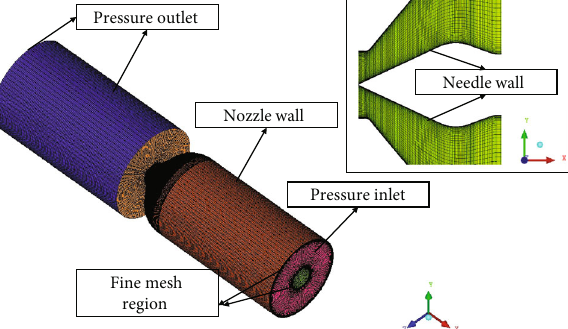
Figure 6: Initial readings of needle